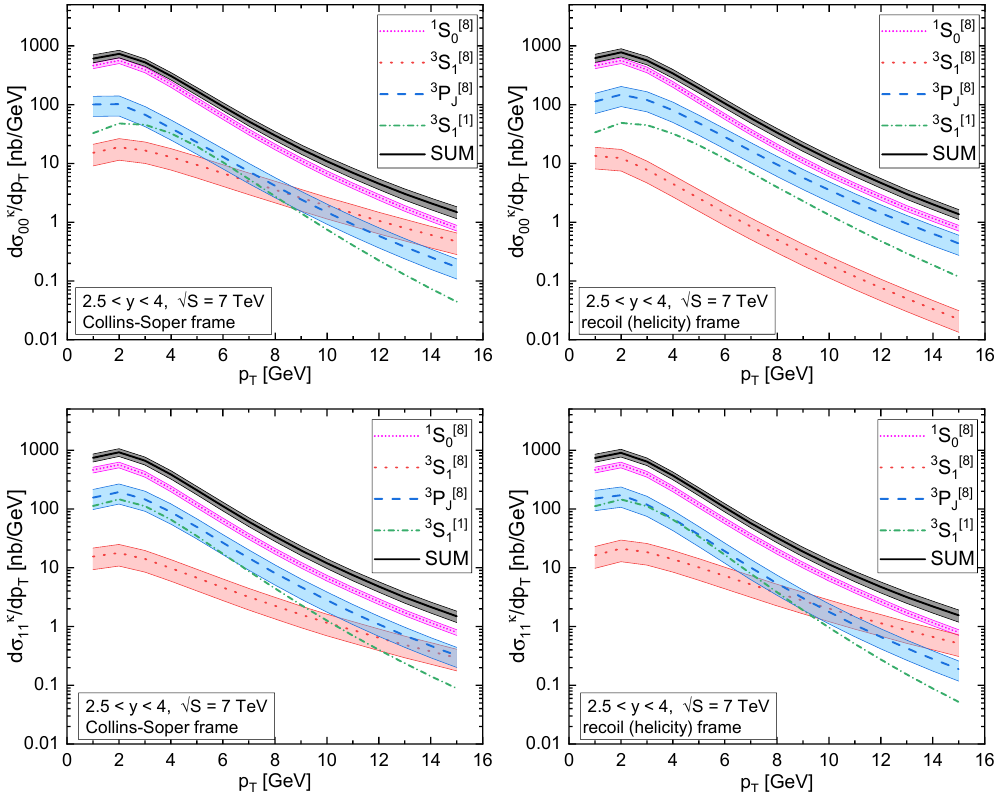
Figure 1 . The spin density matrix elements d(cid:27) (cid:20) Soper frame (left column) and in the recoil (right column) frame as functions of the J= transverse momentum p T . The di(cid:11)erent curves represent contributions from di(cid:11)erent intermediate quantum states. \SUM" represents the sum over all